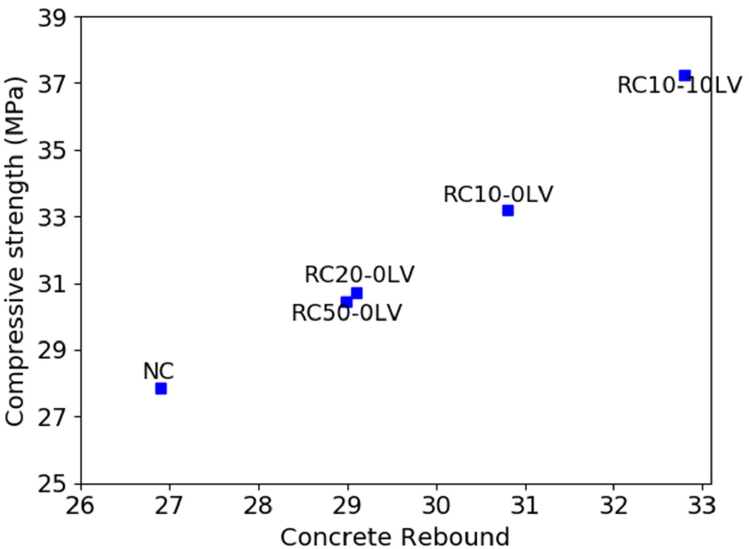
Figure 6. Concrete rebound vs. Compressive strength.